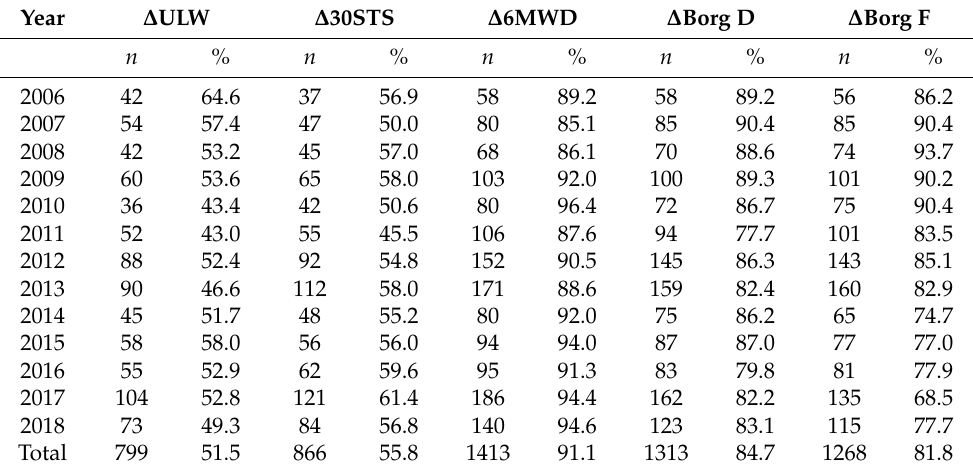
Table 3. Patients reaching the MCRC in each outcome following the CR and during the consid- ered timespan.